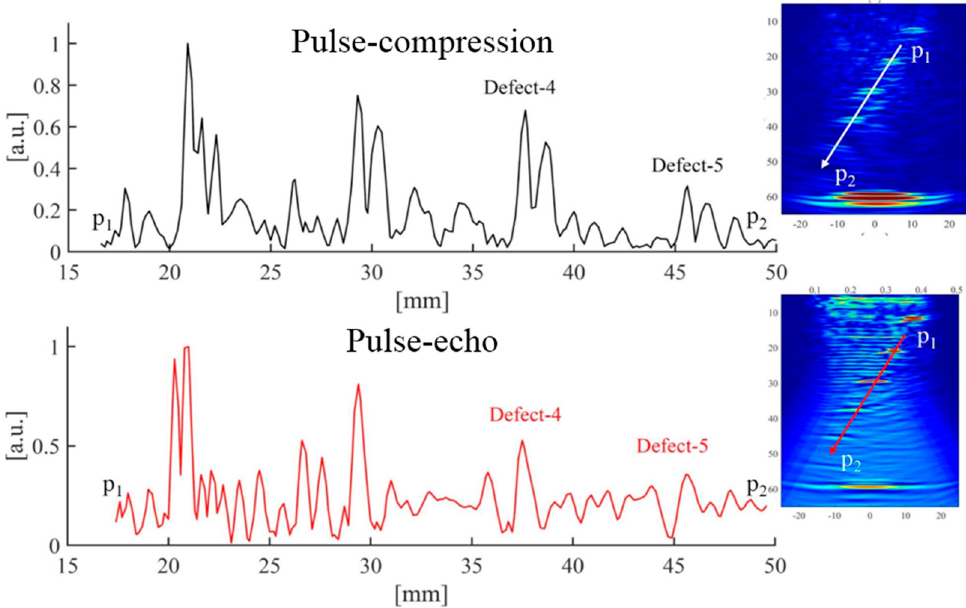
Figure 13. The plot is a cross-section line through the position of the defects which shows the intensity of the TFM image and highlights the obtained SNR at the defects. ( Top ) Intensity of the defects in the TFM image of the PuC-based system shown in Figure 7. ( Bottom ) Intensity of the defects in the TFM image of the standard, commercial pulse-echo system shown in Figure 8.